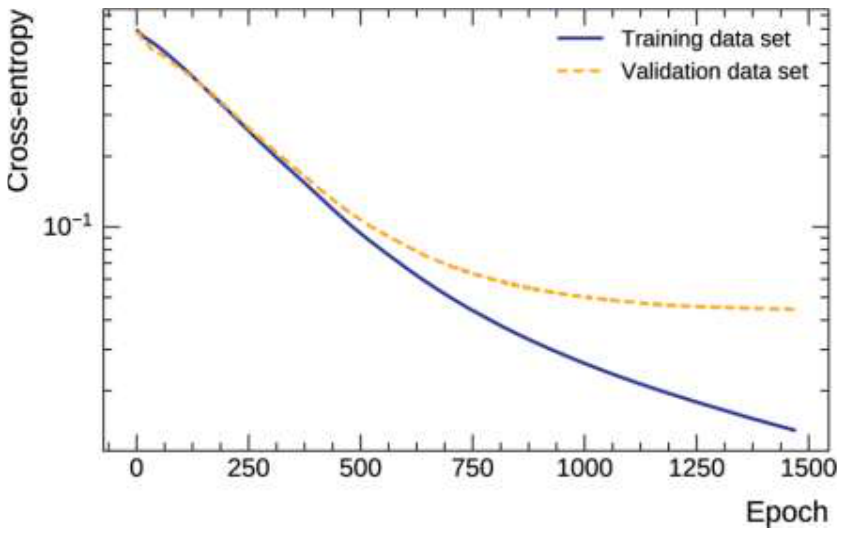
Figure 4. The cross-entropy value in the training and validation operations. Figure 5 depicts the training and validation loss values versus the mean square error of the proposed classification model. The results are calculated by the PSP and averaged over 100 cases, which are then divided into sub-structures. Each sub-structure depicts the probability of the corresponding experiment. The probability values define the percentage of the data accommodating various square error values.